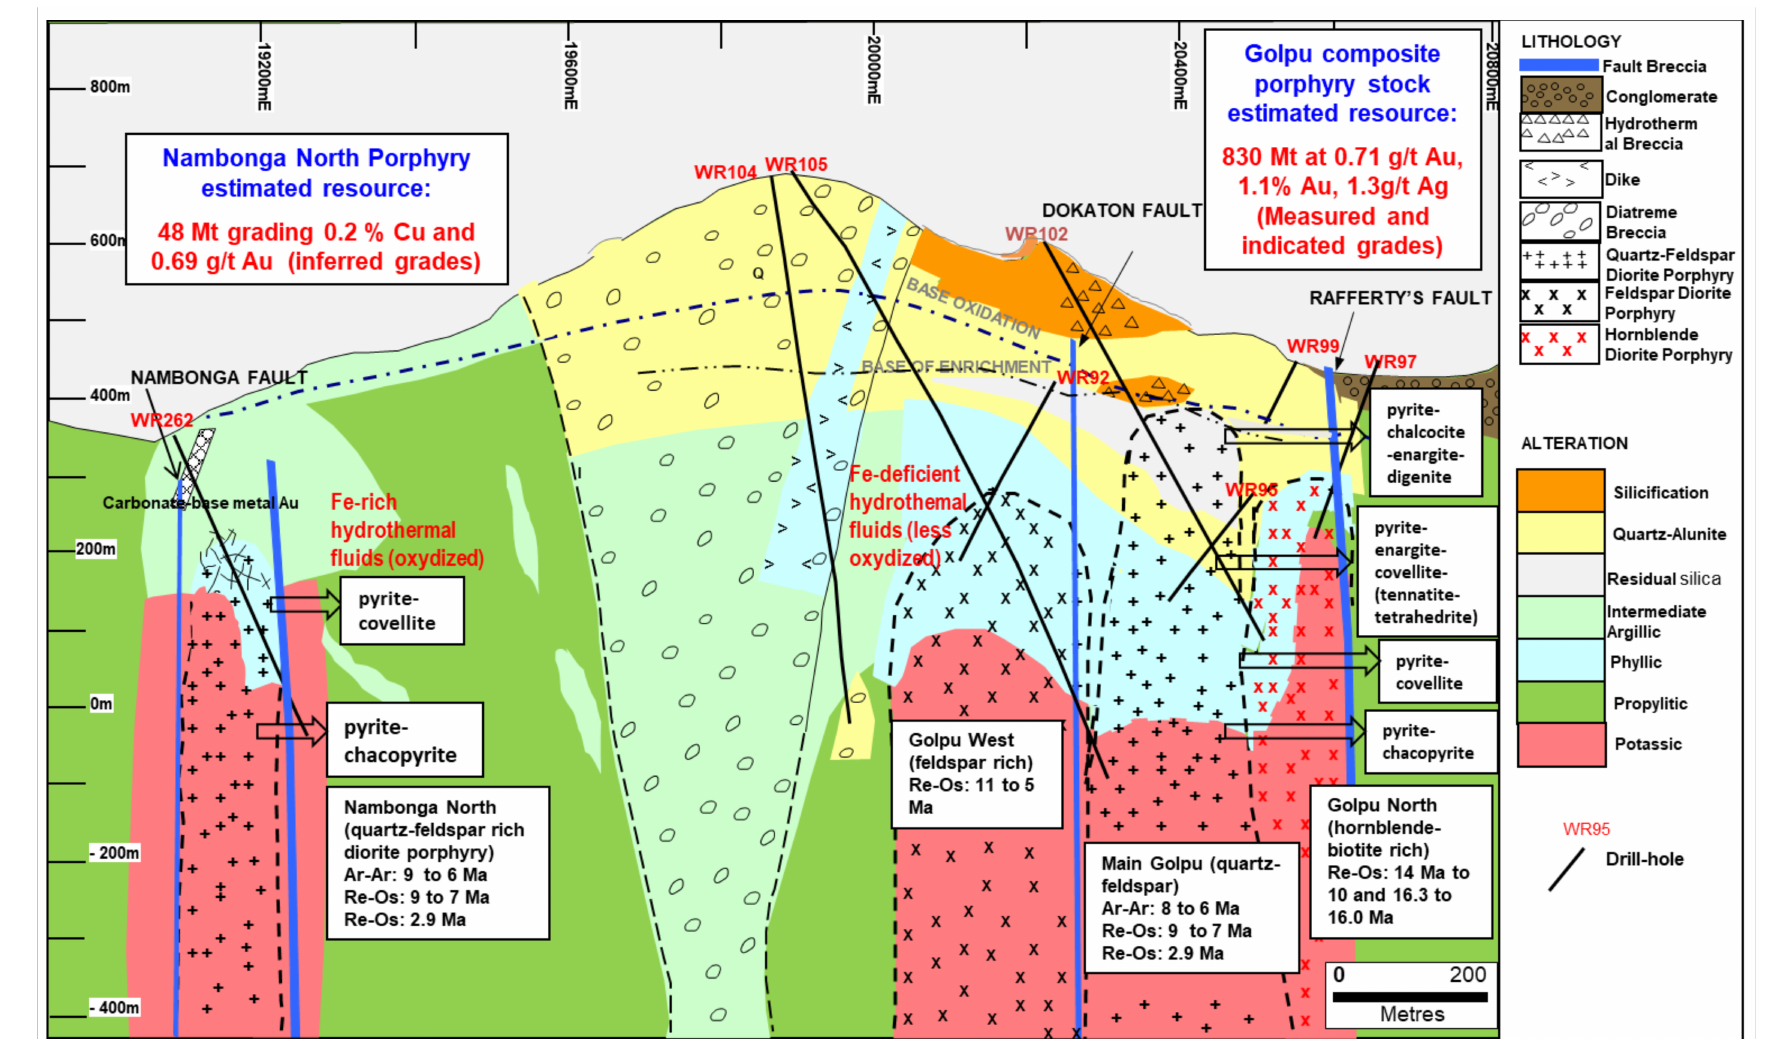
Figure 4. Geological cross-section of the Golpu and Nambonga North porphyry systems. Age dating results are from Lunge (2013). The mineral resources estimates were taken from the Newcrest Mining Limited Technical Report